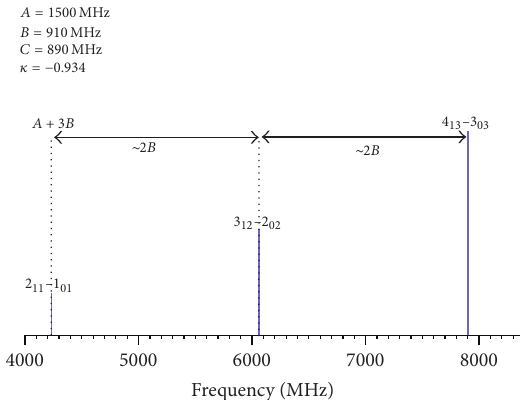
-type -branch progression of transi- 𝑏𝑏 𝑄𝑄